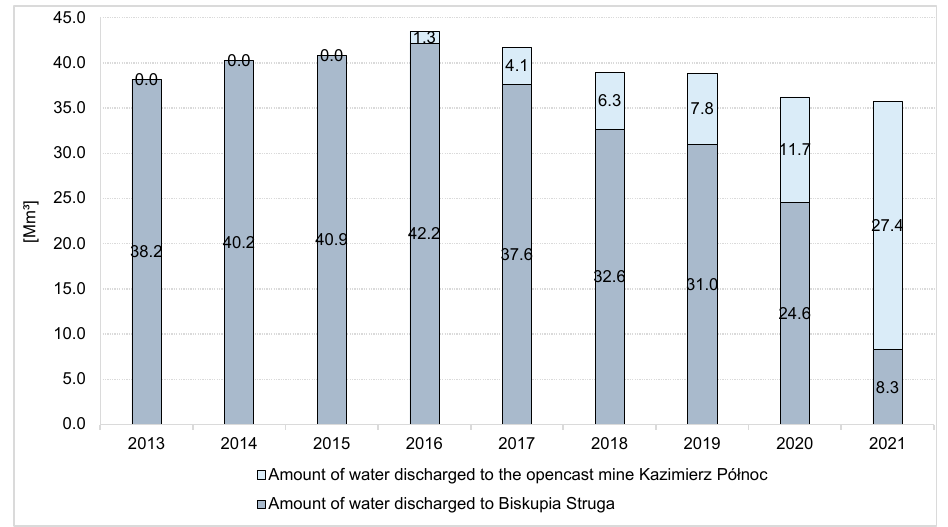
Figure 8. Amount of mine water discharged to the post ‐ mining water reservoir Kazimierz Pó ł noc in comparison to water discharged from the opencast mine Jó ź win IIB (own elaboration based on data of PAK KWB Konin).